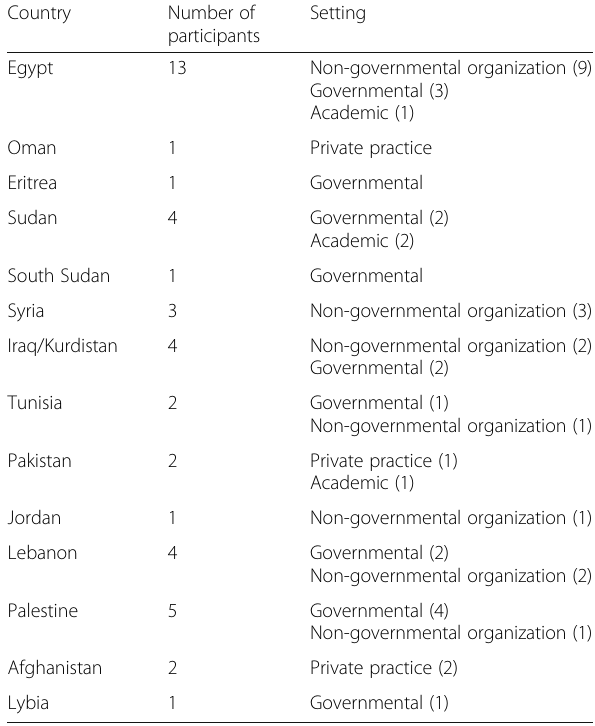
Table 1 Breakdown of participant countries and occupations